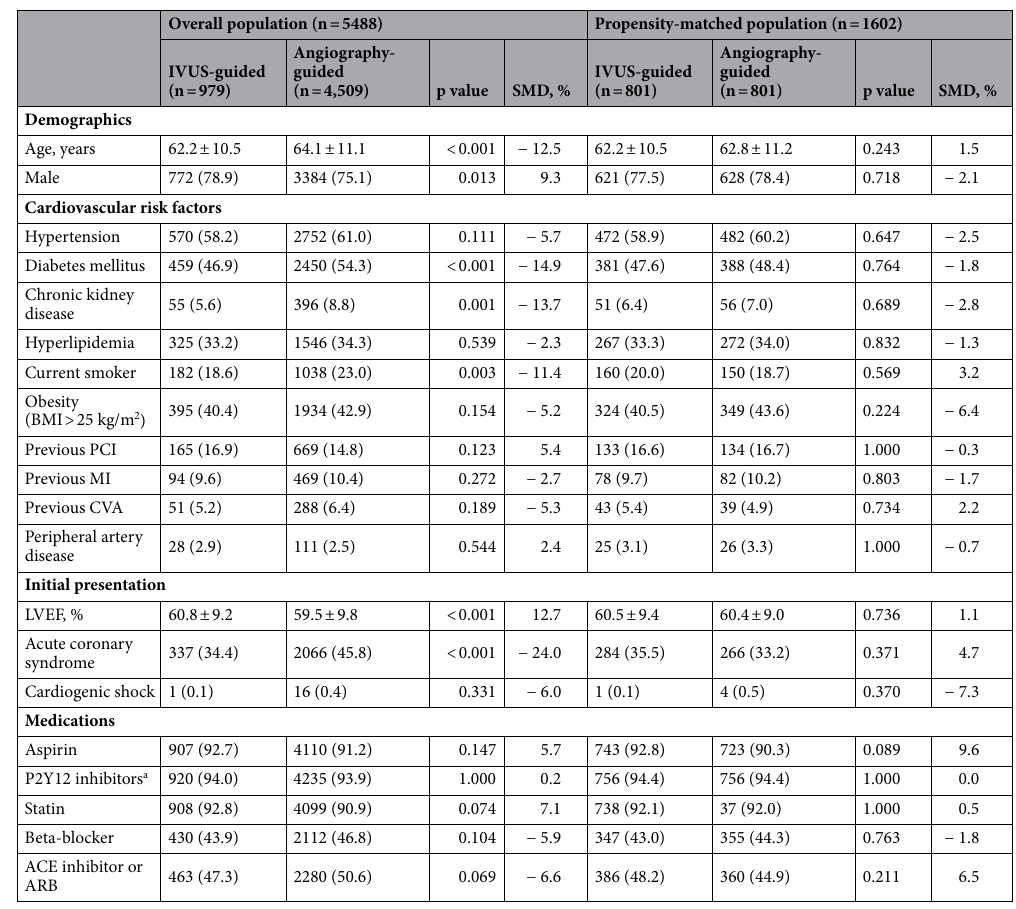
Table 1. Baseline characteristics according to use of IVUS in overall and propensity matched populations. ACE, angiotensin converting enzyme; ARB, angiotensin receptor blocker; BMI, body mass index; CVA, cerebrovascular accident; IVUS, intravascular ultrasound; LVEF, left ventricular ejection fraction; MI, myocardial infarction; PCI, percutaneous coronary intervention; SMD, standardized mean difference. a P2Y12 inhibitors were clopidogrel, ticagrelor, or